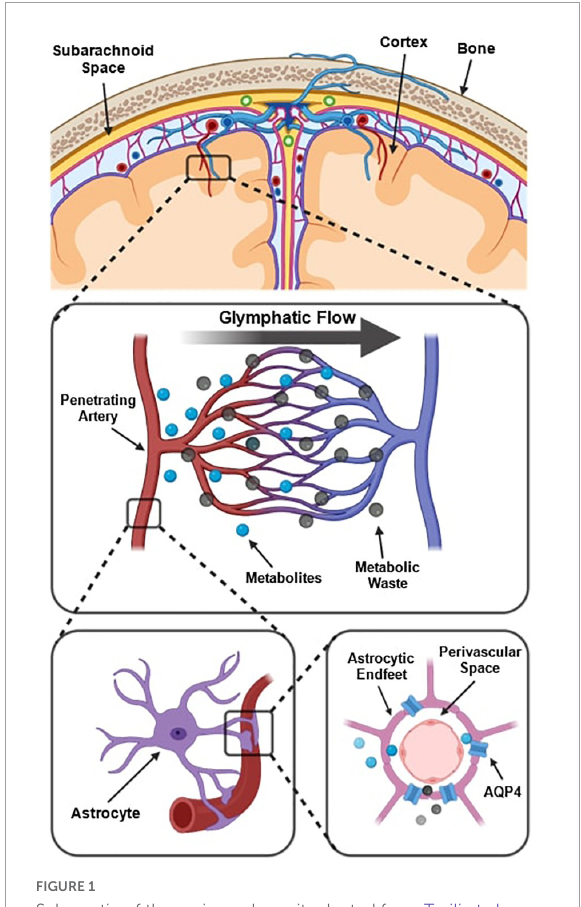
FIGURE1 Schematic of the perivascular unit adapted from Troili et al. (2020). (Top) Arteries and veins from the subarachnoid space penetrate the parenchyma, perpendicular to the cortical surface. (Middle) Metabolites are extruded from arterioles and into the extracellular space, whilst metabolic waste flows towards the perivenular spaces for glymphatic clearance from the neuropil. (Bottom left) Astrocytic endfeet enclosing a penetrating arteriole which forms the perivascular space. (Bottom right) Aquaporin-4 trans-membrane channels line the astrocytic end-feet and facilitate the exchange of cerebrospinal fluid and interstitial fluid between PVS and extracellular space. Reproduced under the Creative Commons Attribution 4.0 International License (https://creativecommons.org/licenses/by/